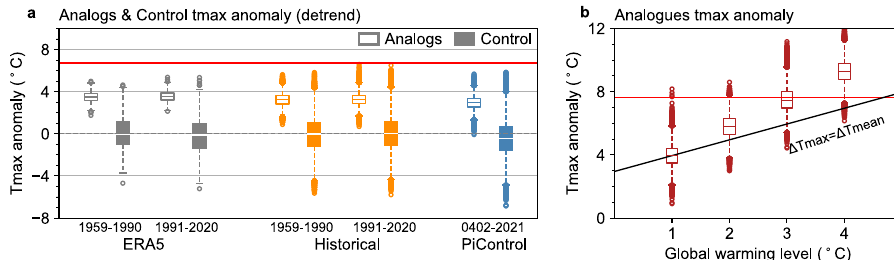
(unit: °C) for fl ow analog days in given levels of projected global warming. The black line corresponds to Δ Tmax= Δ Tmean, indicating the increase in extreme temperature is equal to global mean temperature. The red line indicates the max- imum temperature anomalies of the average of 27 June – 3 July 2021 from ERA5 in both fi gures.